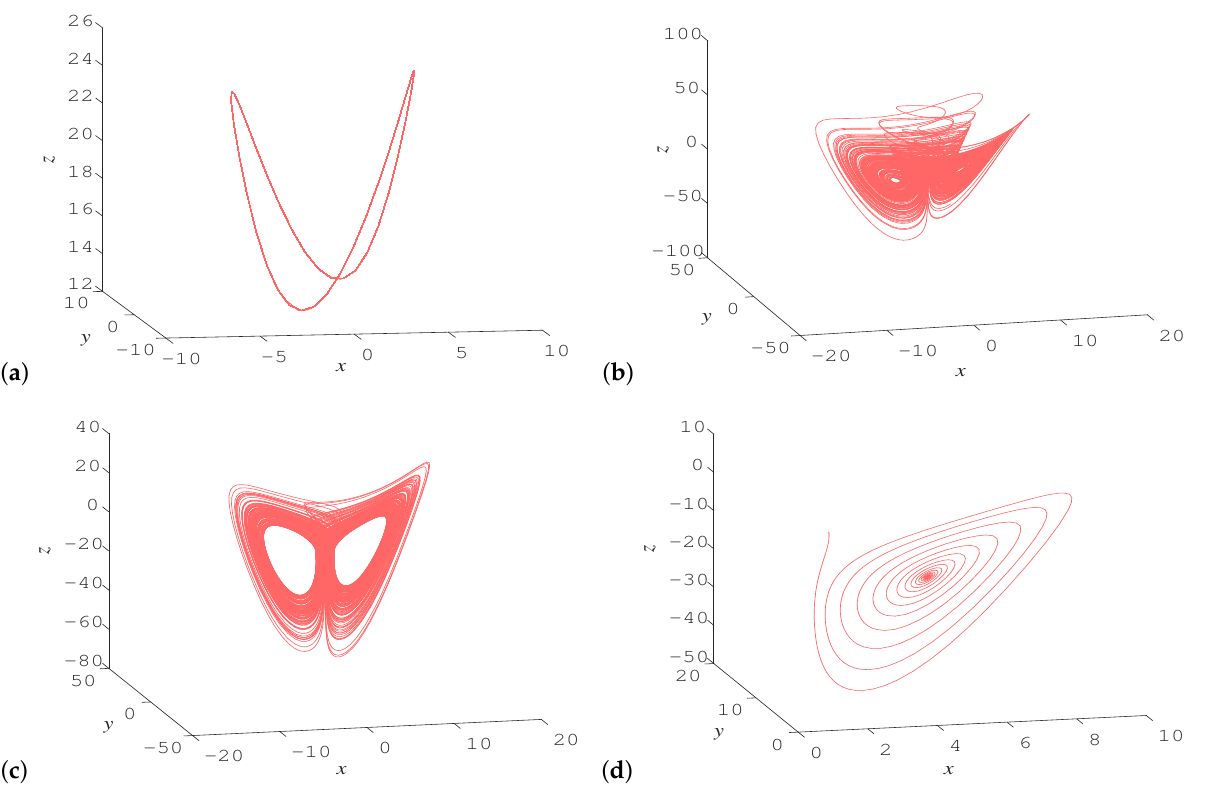
Figure 10. Three-dimensional views of rich dynamical behaviors with parameters a = 12, b = 100, and k = 4.6: ( a ) c = − 10, ( b ) c = − 2, ( c ) c = 8, and ( d ) c = 15. The initial values of ( x ) = ( 1,1,1 ) were selected. 0 , y 0 , z 0